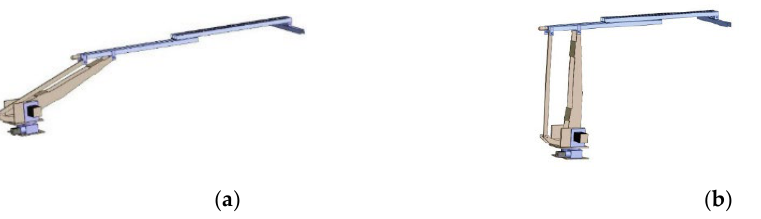
Figure 3. CAD model for ( a ) Fully-extended Configuration, ( b ) Vertical Half-extended Configuration.